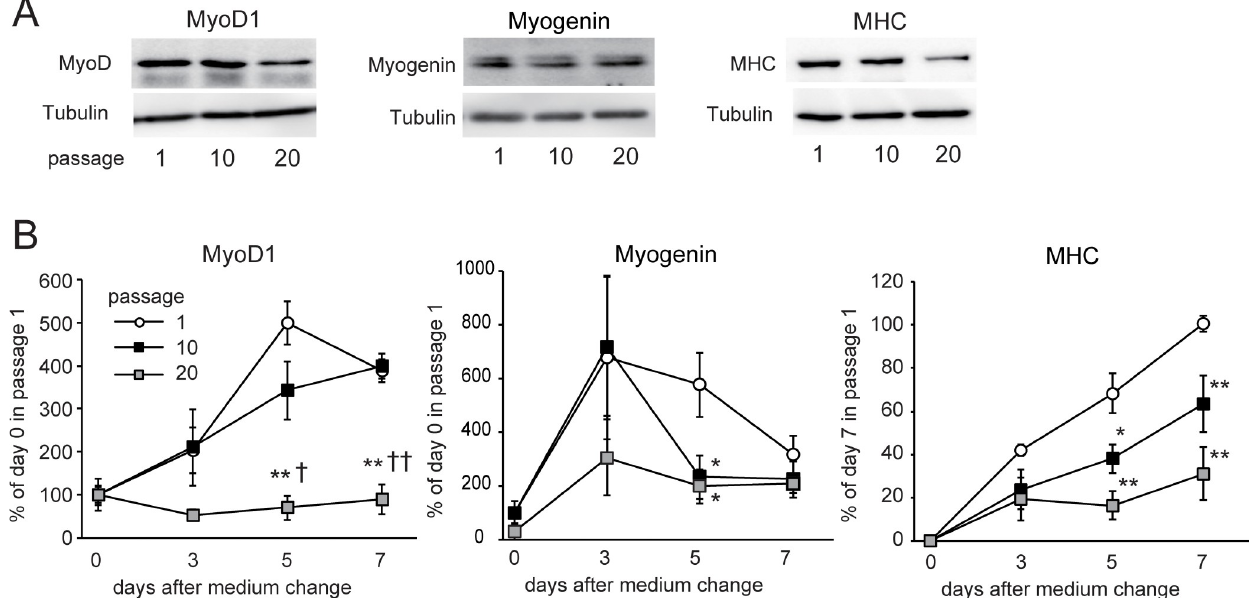
Fig 3. Effect of replicative senescence on myogenic marker expression during myogenic differentiation of C2C12 cells. Panel A shows representative Western blots of MyoD1, Myogenin, myosin heavy chain (MHC), and tubulin (as an internal control) in C2C12 cells after myogenic differentiation. Cells were collected 7 days after differentiation for MyoD and MHC or 5 days after differentiation for myogenin. Panel B shows the time course of MyoD1, myogenin, and MHC protein expression after changing the medium for myogenic differentiation. The band density of MyoD, myogenin, or MHC was normalized with that of tubulin. The normalized density was compared with the average of the normalized density in passage 1 just before myogenic differentiation (day 0) in the MyoD and myogenin expressions. Because MHC expression was undetectable on day 0, the normalized density was compared with the average of the normalized density in passage 1, 7 days after myogenic differentiation. Data are presented as means ± SE (n = 4 dishes). � P < 0.05, �� P < 0.01 vs. passage 1 at each time point; †P < 0.05, ††P < 0.01 vs. passage 10 at each time point (Tukey–Kramer test).